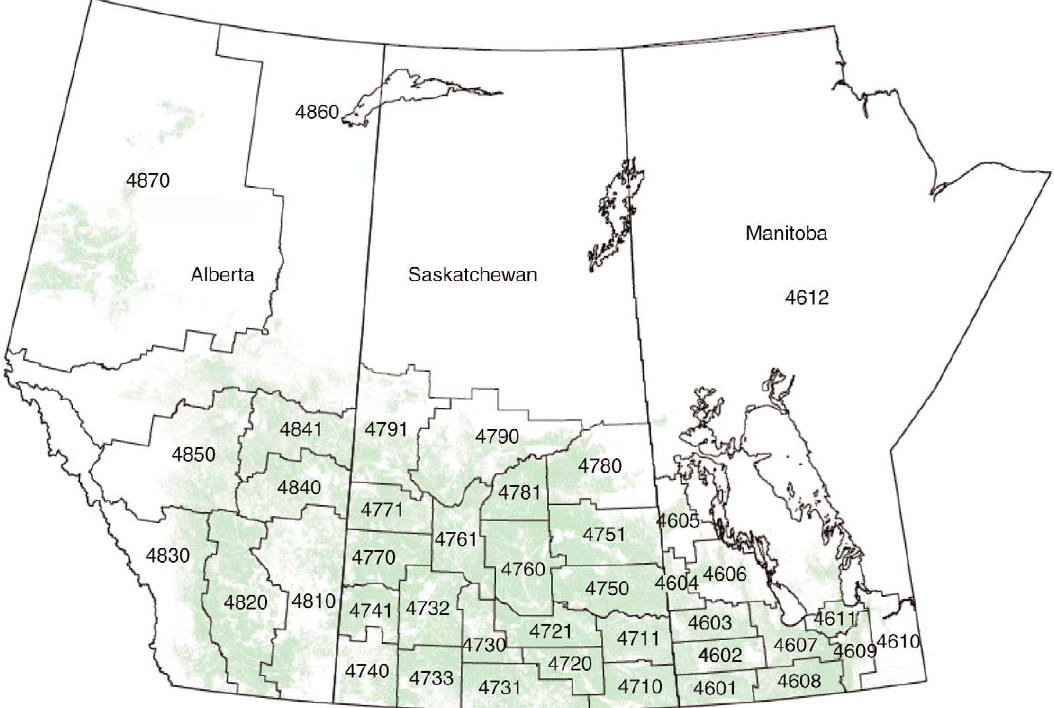
Figure 1. Agricultural crop districts in Saskatchewan from NO.4710 to NO.4791 on the Canadian prairies with shaded area showing cropland extracted from the map Land Cover for Agricultural Regions of Canada, circa 2000 (Agriculture and Agri-Food Canada 2013). Numbers are the codes of the Census Agricultural Regions.